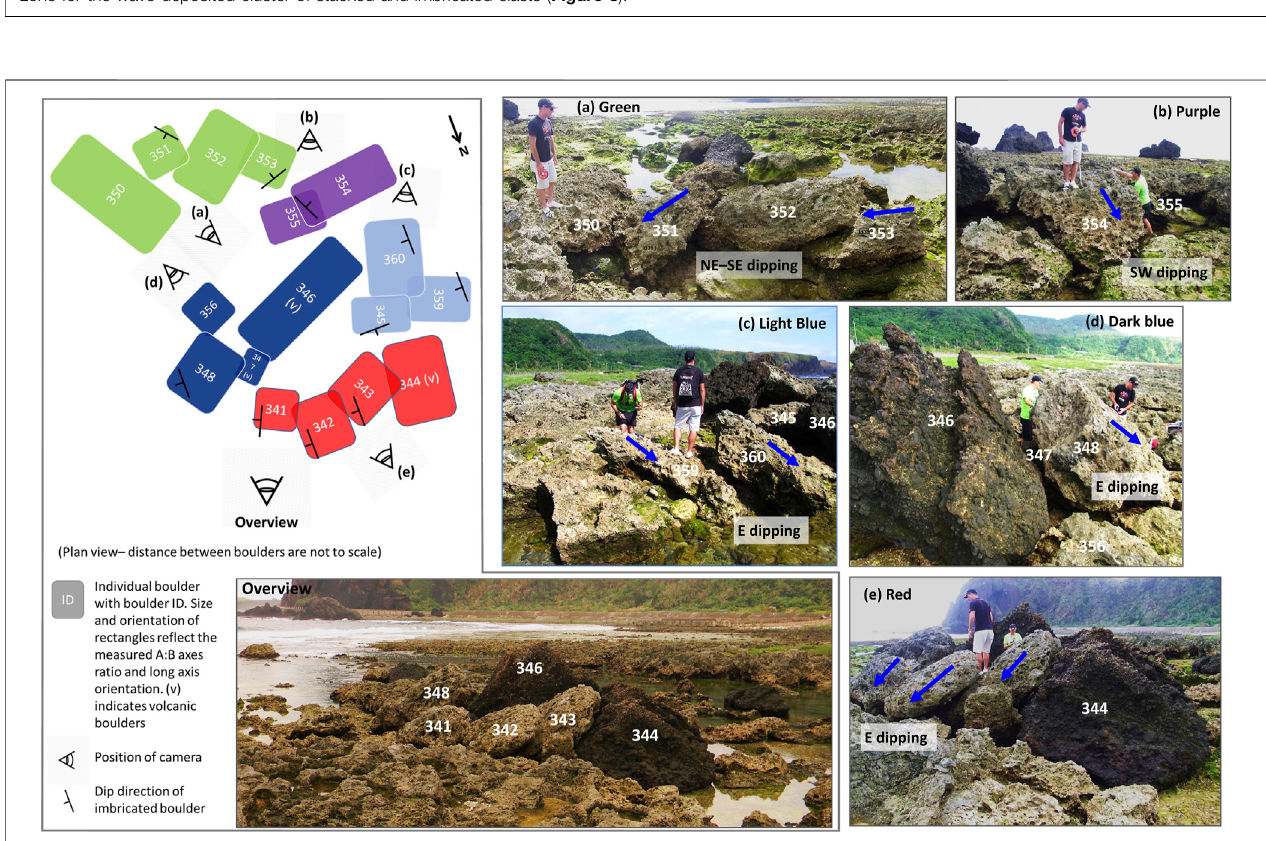
FIGURE 9 | Different views of the cluster of large coastal boulders of mixed lithologies (limestone and volcanic), deposited at the head (i.e., landward end) of remnant spur-and-groove depressions that today form shallow tidal pools on the emerged Holocene platform of Dahu Reef. The location of this cluster is shown in Figure 3B2 . The top-left illustration shows the arrangement of boulders in this cluster. Most boulders are overlapping or leaning on another individual (indicated by a rectangle partly overlaying another in the illustration). Ten boulders are imbricated, or leaning on other clasts with an inclined/dipping surface. Dip directions are indicated by a dip symbol on rectangles, and by blue arrows in the photos. Boulders are colour-coded in the plan view illustration to indicate which photo (A – E) and which stack of clasts they are in.